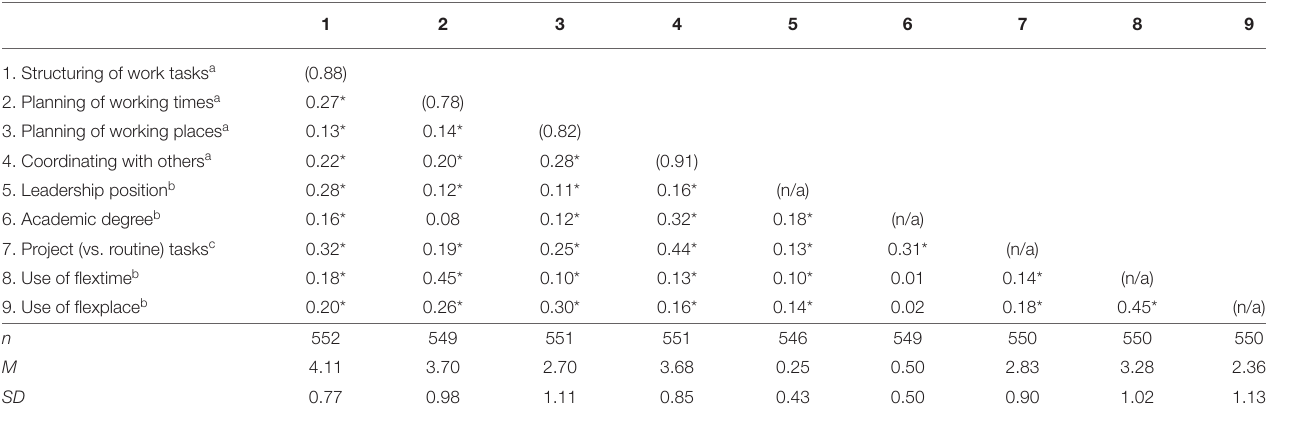
TABLE 6 | Descriptive statistics, Cronbach’s alphas, and correlations for study